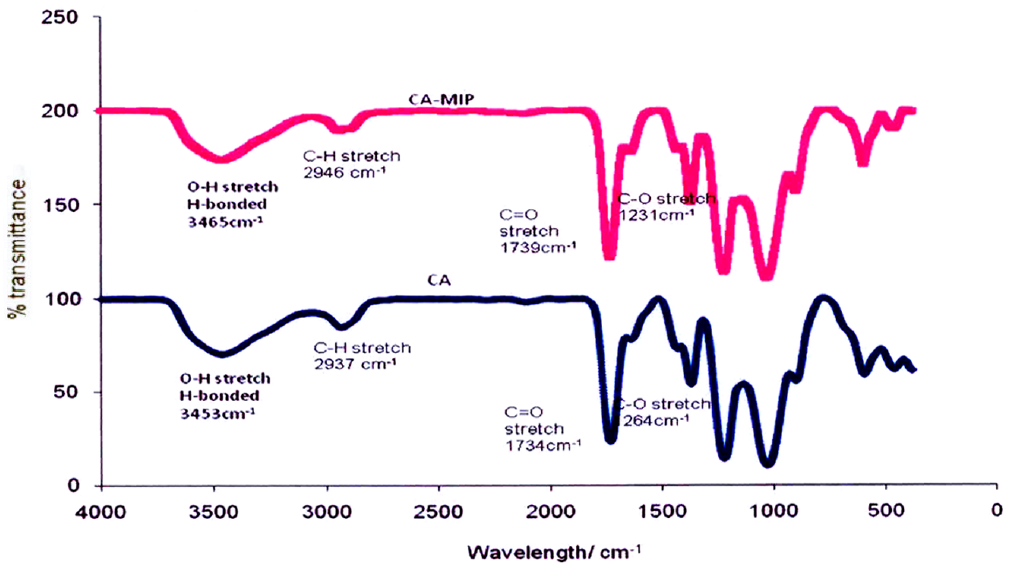
Figure 1. FTIR spectra for CA and